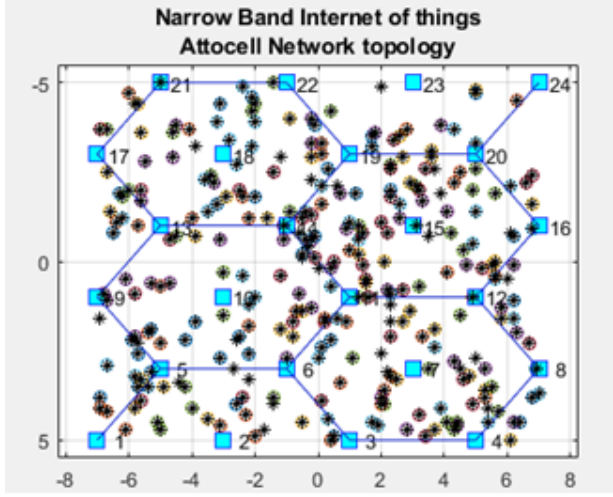
Figure 28. NB-IoT network without a LEACH scheme showing all nodes sending data at the same time (300 users).